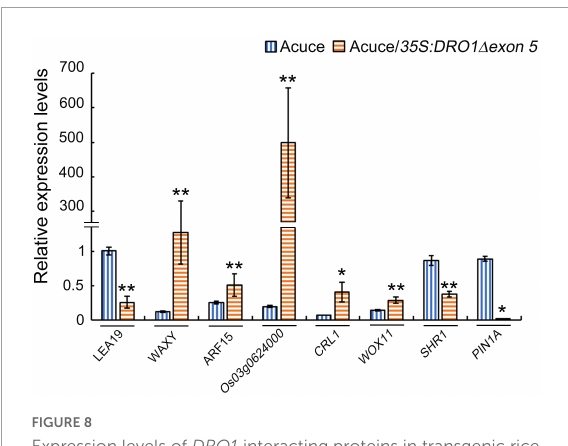
FIGURE8 Expression levels of DRO1 interacting proteins in transgenic rice line. Relative expression levels of LEA19 , WAXY , ARF15 , Os03g0624000 , CRL1 , WOX11 , SHR1 , and PIN1A genes in the primary roots of rice seedlings Acuce and transgenic rice line #8 were detected by real-time PCR. The Actin gene was used as an internal control. The data presented here represent at least three biological replicates. Data are means ± SD; * P < 0.05, ** P < 0.01 (SPSS